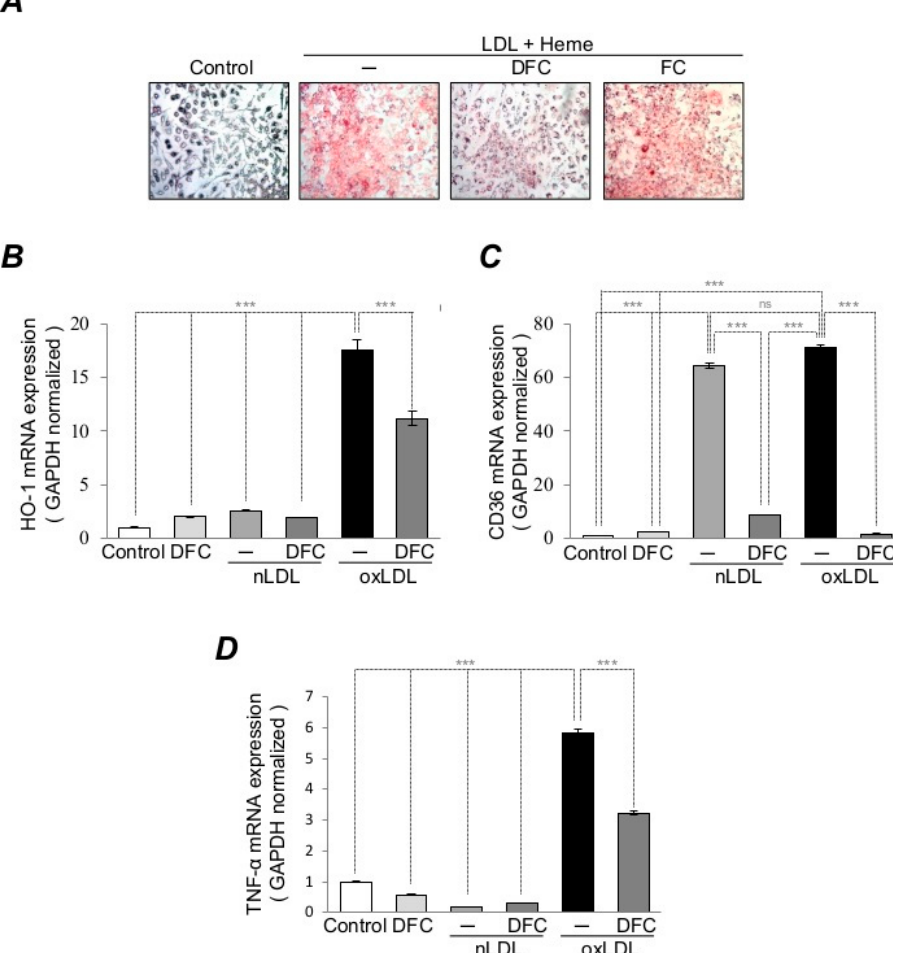
Figure 5. DFC inhibits foam cell formation and suppresses macrophage activation provoked by heme-catalyzed LDL oxidation. ( A ) RAW 246.7 macrophages were preincubated with DFC (50 µmol/L) or FC (50 µmol/L) for 16 h, then exposed to LDL (100 µg/L)-heme (5 µmol/L) solution in the presence or absence DFC (50 µmol/L) and FC for (50 µmol/L) for 24 h. Representative Oil Red O staining of RAW 246.7 macrophages are shown. ( B – D ) RAW 264.7 cells were grown in 6-well plates and pretreated with DFC (50 µmol/L) for 16 h. Cells were then exposed to native LDL (50 µg/mL) or oxLDL (50 µg/mL) for 6 h. Relative mRNA expression for HO-1, CD36 and TNF- α was assessed by Real-Time qPCR The graph shows the mean ± SEM of three separate experiments. *** p < 0.001, ns: not significant.